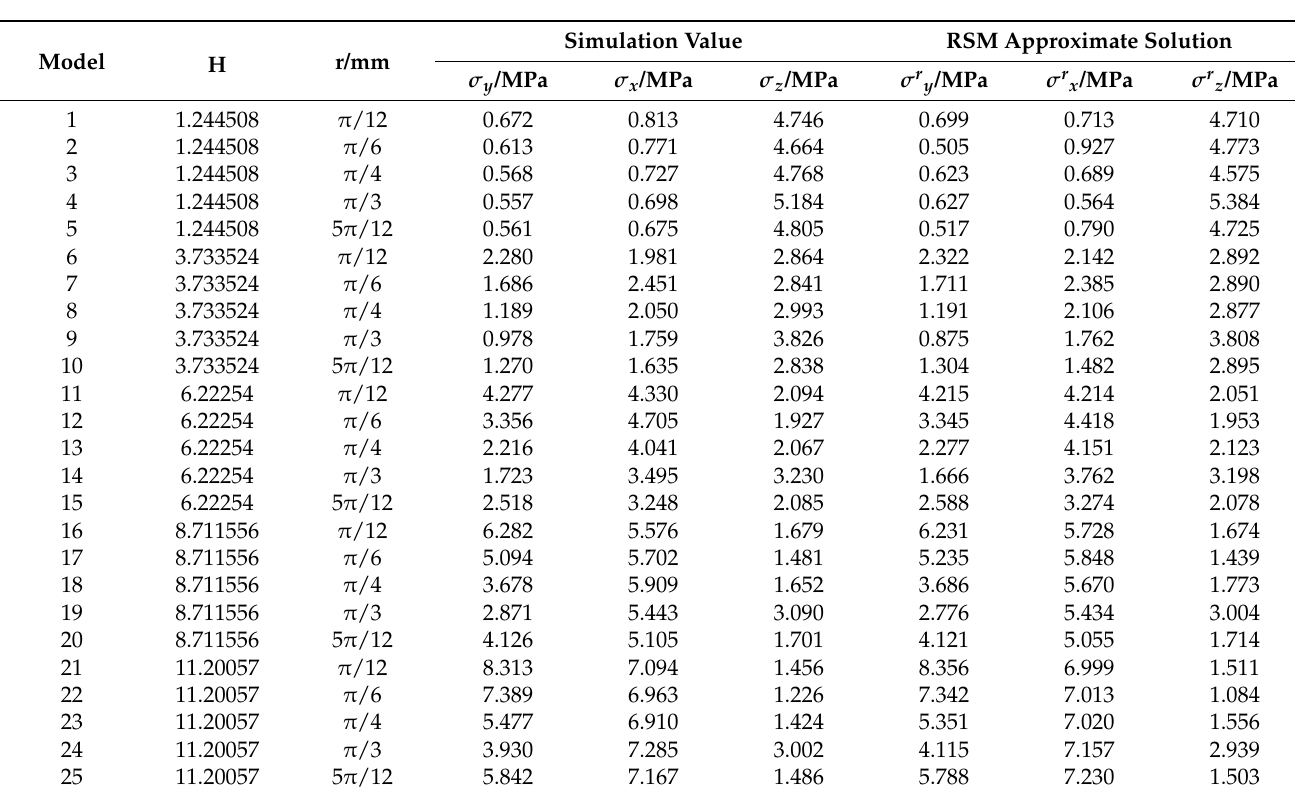
Table 2. Comparison of response surface approximate solution and simulation values of mean stress for origami honeycomb structures.